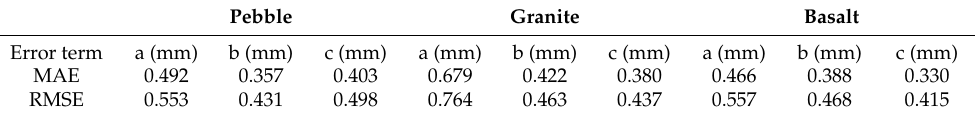
Table 1. Error term